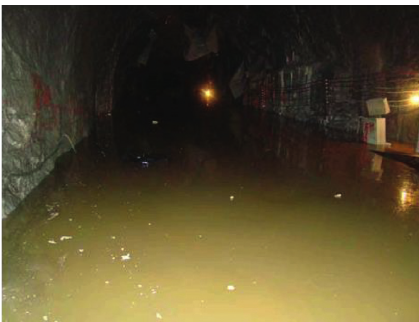
Figure 5: The picture of water discharge of the roadway in 8h after water inrush.